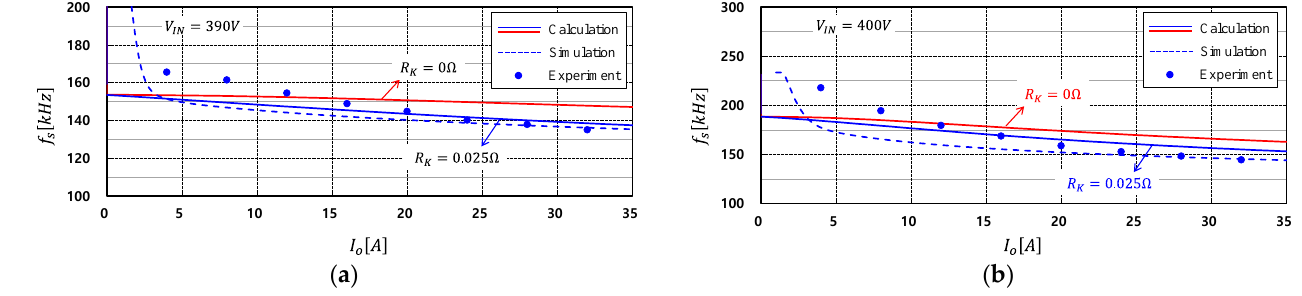
Figure 21. Load characteristics of switching frequency: ( a ) Input voltage of 390 V; and ( b ) input voltage of 400 V.